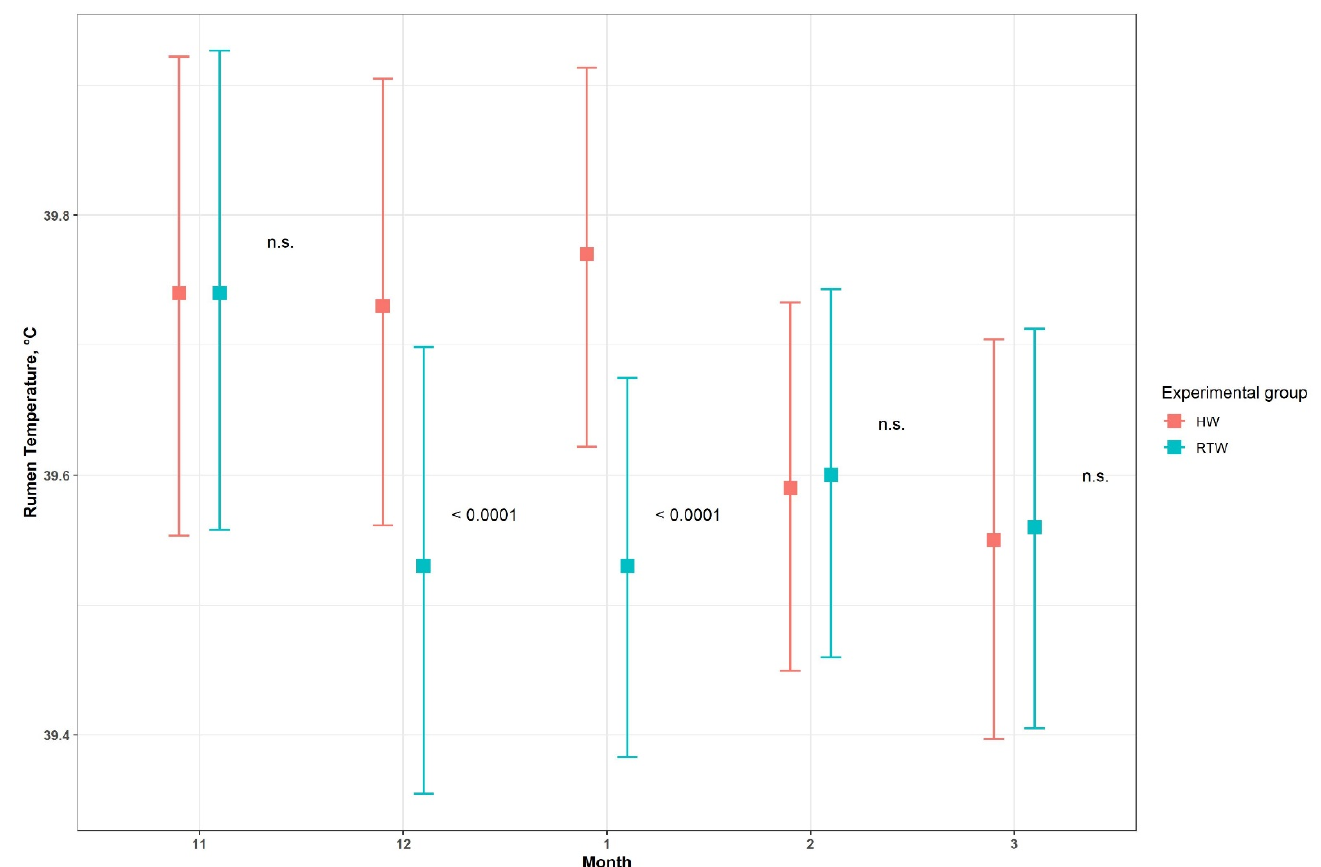
Figure 5. Rumen temperature: the interaction between month and experimental group.